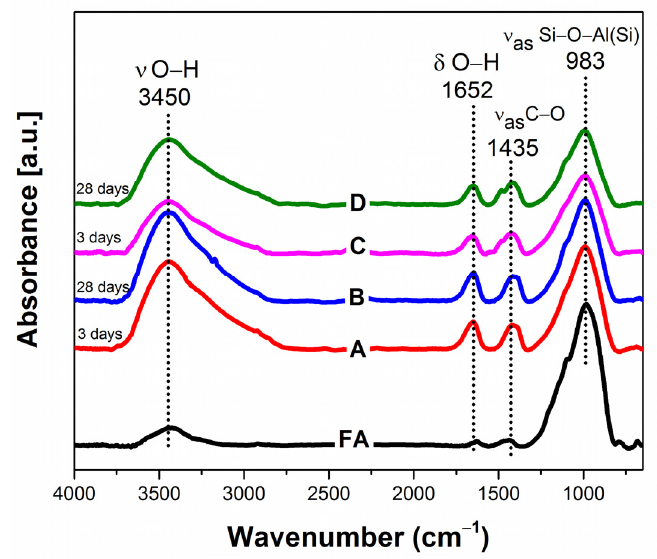
Figure 5. ATR-FTIR spectra of class C fly ash and selected geopolymer samples with curing temperature of ( A , B ) 30; and ( C , D ) 90 °C.